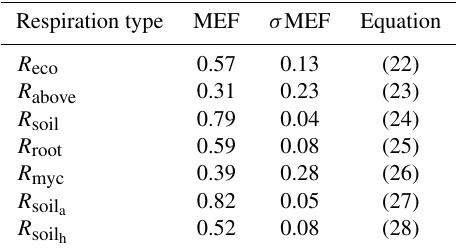
Table 3. Modelling performance for all extracted model structures after cross-validation over 90